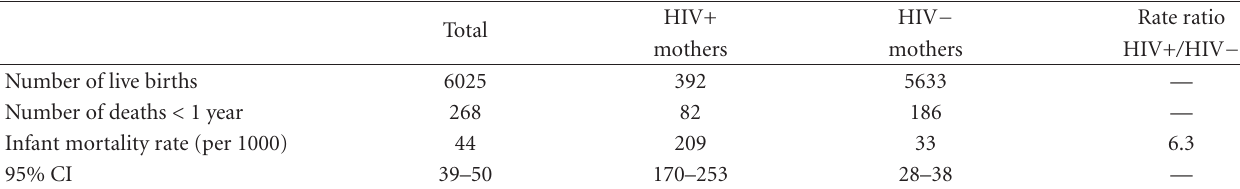
Table 5: Mortality rates in children less than 1 year according to the HIV status of their